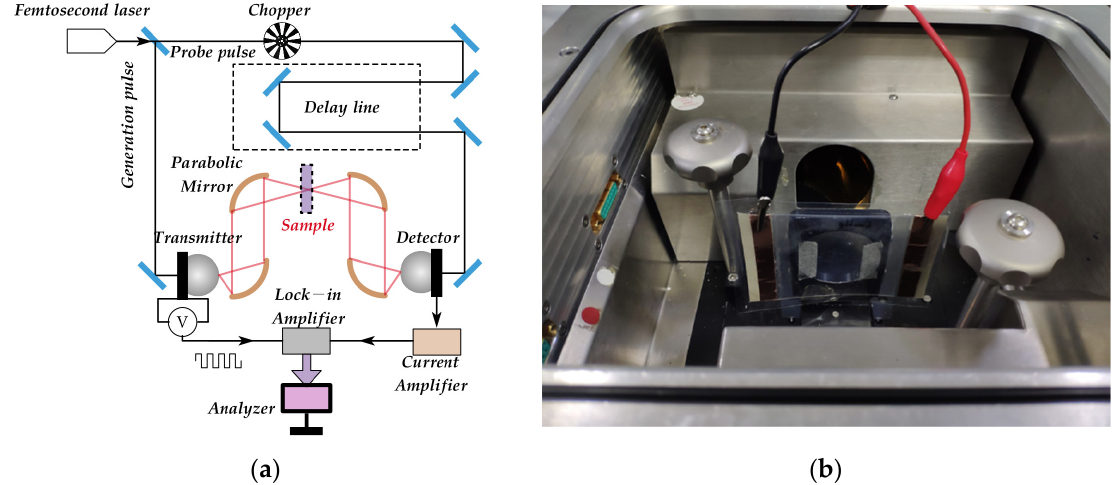
Figure 11. ( a ) The diagram of THz-TDS system; ( b ) sample placed between parabolic mirrors.